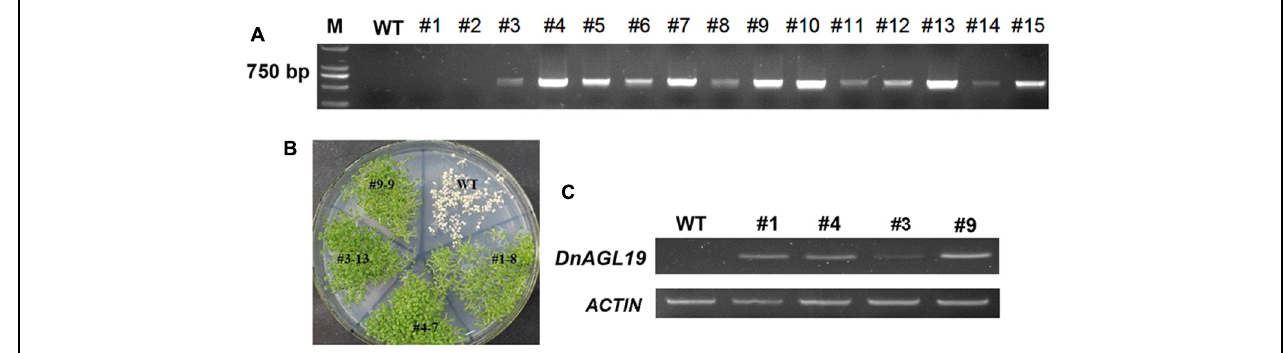
FIGURE 4 | Screening for homozygous DnAGL19 overexpressing Arabidopsis thaliana lines. (A) Detection of the DnAGL19 insertion in putative transgenic lines. Genomic DNA was extracted from wild type A. thaliana and putative transgenic lines marked #1 to #15. The DnAGL19 sequence (639 bp) was amplified using genomic DNA as a template. (B) Growth of identified homozygous plants on a MS plate containing 50 mg/L kanamycin. Lines # 1, # 3, # 4, # 9 and wild type are shown. (C) Expression of DnAGL19 in transgenic lines. Total RNA was extracted from lines # 1, # 3, # 4, # 9 and wild type seedlings and reversed transcribed. RT-PCR was performed to detect the expression level of DnAGL19